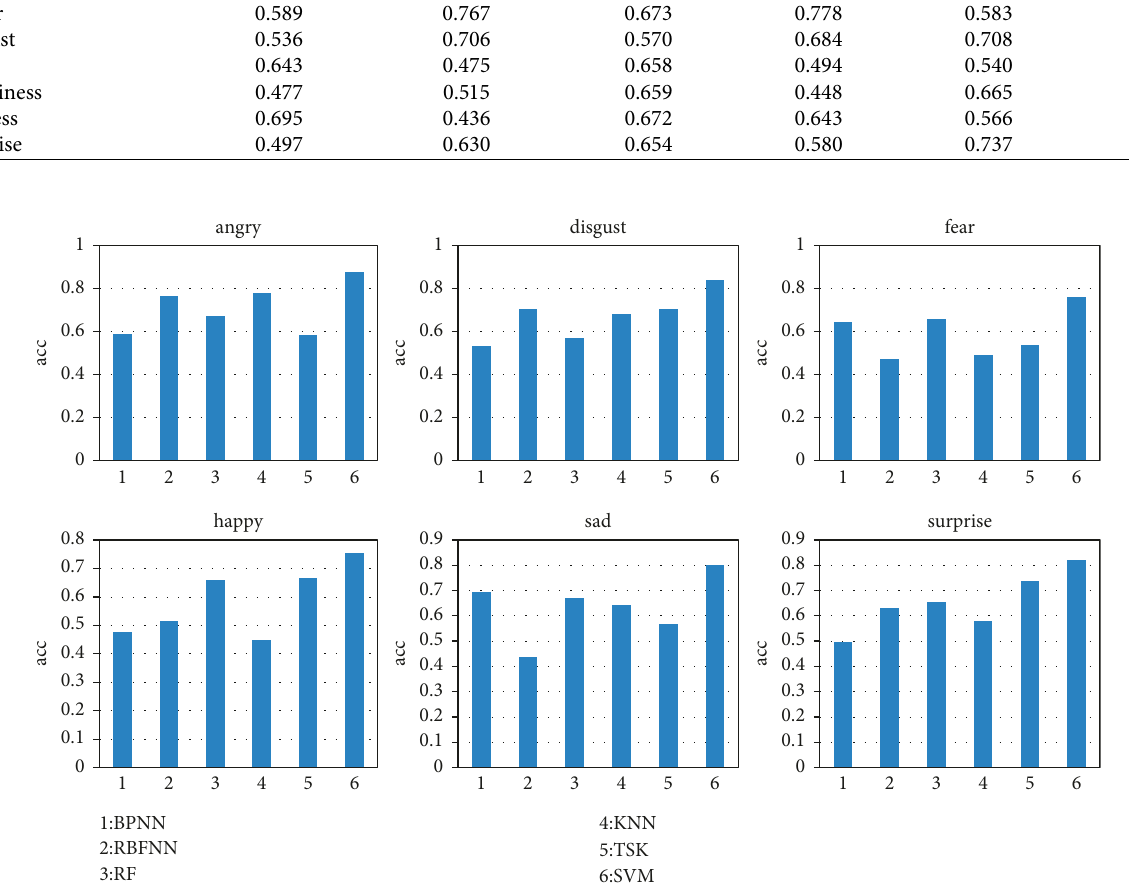
Figure 3: Comparison of emotion recognition results based on